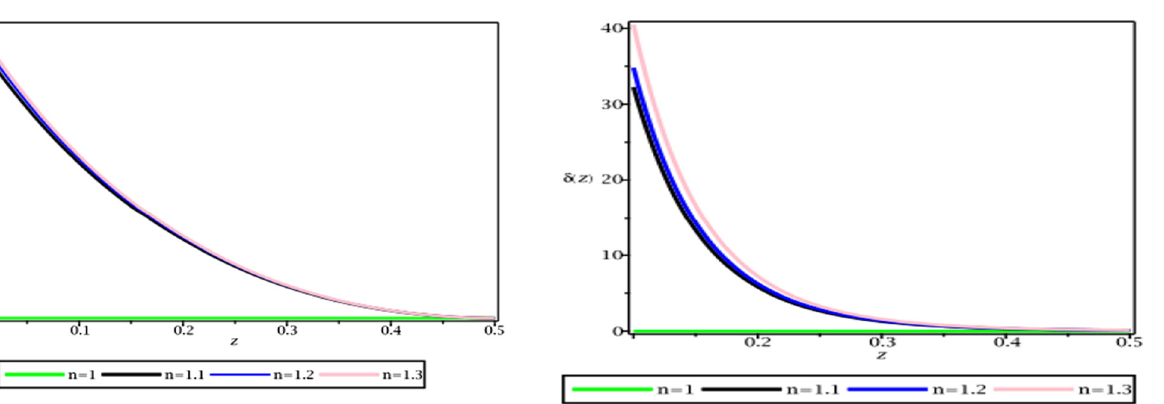
Fig. 1 The plots show the evolution of the energy-density fluctuations ofdustgivenbybyEq.(66)ofthelong-wavelengthmodesfor α R + β R n model (black, blue and pink) together with Λ CDM case (green) given by Eq.(69); for β = 0 . 0005, α = 0 . 01, Ω d = 0 . 32, Ω Λ = 0 . 68 and H 0 = 73kms − 1 Mpc − 1